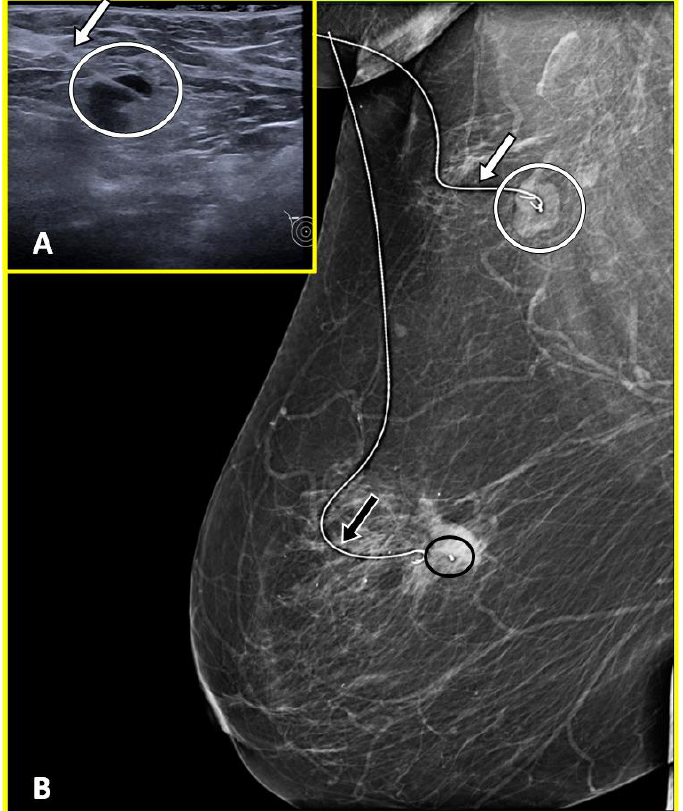
Figure 3. Preoperative wire localization in a 53-year-old woman with right breast tumor and axillary node metastasis. Ultrasound axial image ( A ) shows the metal wire which appears hyperechoic (white arrow) positioned inside the biopsy-proven pathological node (white circle). Post-procedural medio-lateral oblique ( B ) right mammogram confirmed the correct position of the wire (white arrow) within the pathological node (white circle). The wire position (black arrow) adjacent to the marker clip (black circle) within the tumor at 9 o’clock in the right breast is also shown.